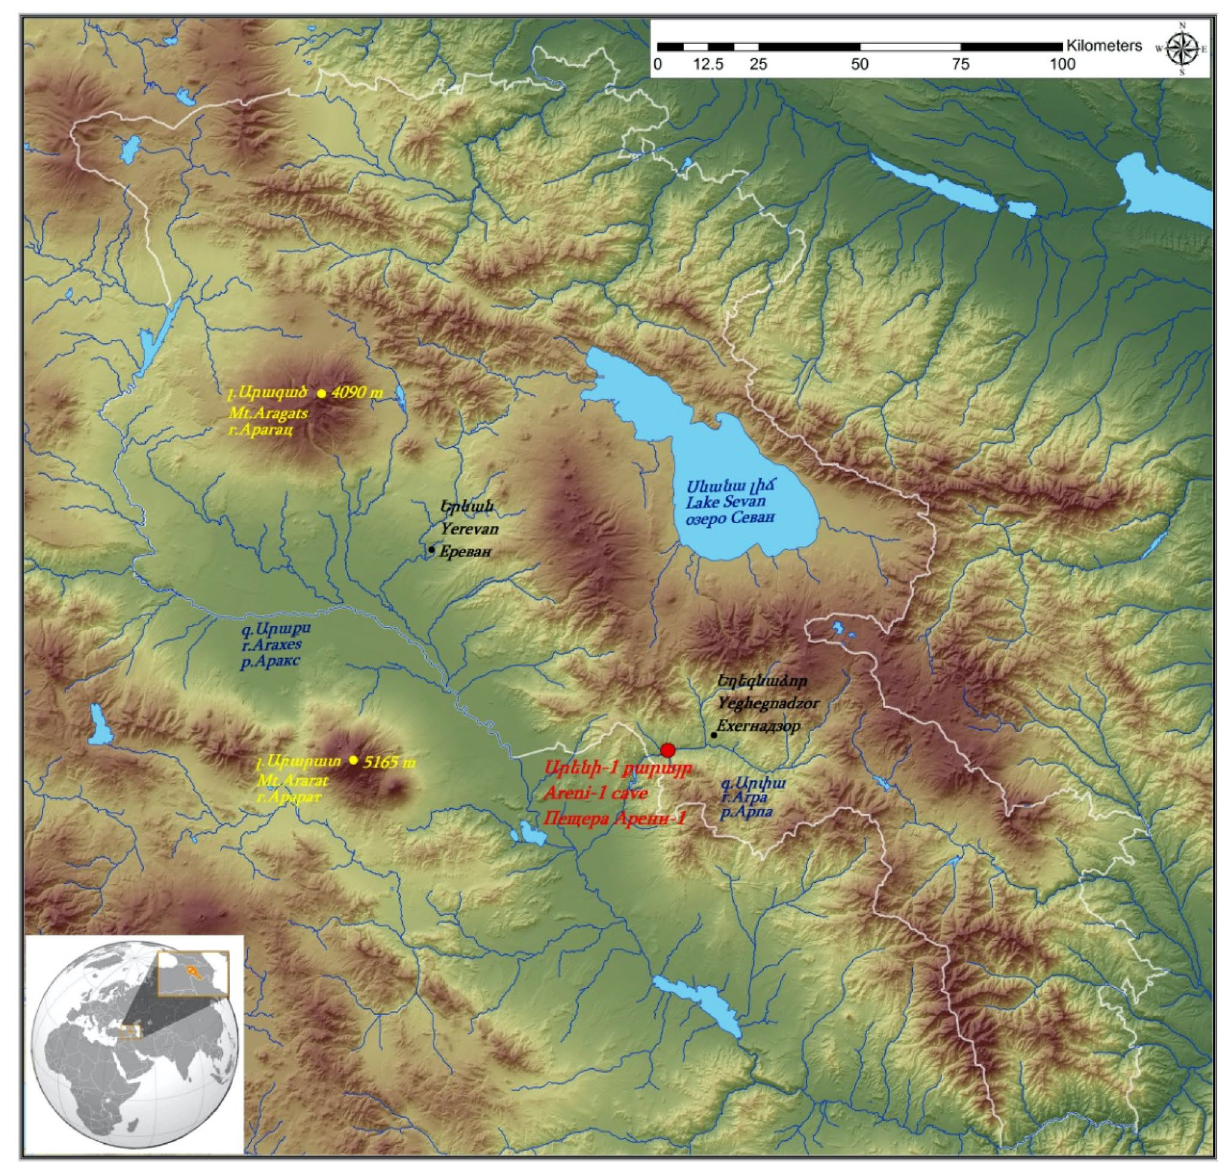
Figure 1. Location of the Areni-1 cave. Small insert at bottom of figure shows location of Armenia within Eurasia. In the large insert, Armenia is shown with the white outline and the location of Areni-1 is indicated in